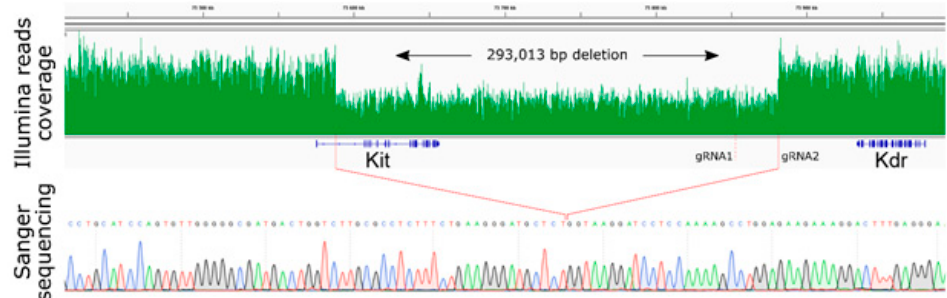
Figure 3. Significant drop in the NGS read coverage visualizes ~293 kb deletion in the heterozygote. Confirmation of the border deletion was performed via Sanger